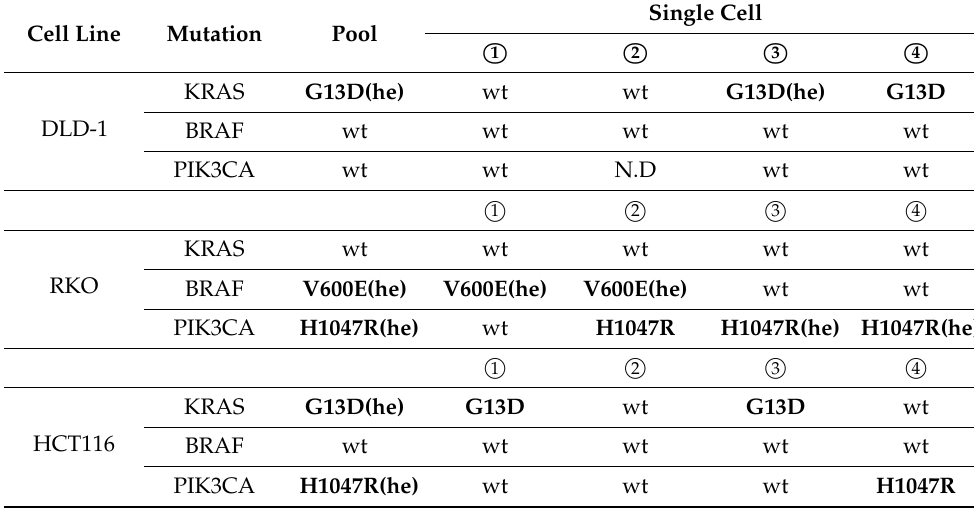
Table 1. Single cell analysis (CRC cell line).